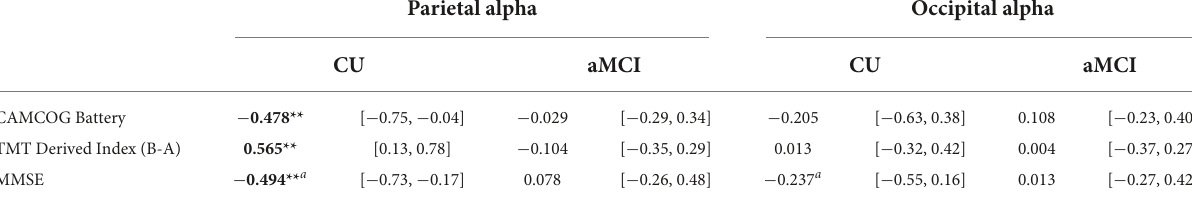
TABLE 7 Correlation coefficients (Pearson’s r ) and correspondent 95% CI between eLORETA source solutions (normalized alpha current source density) of parietal and occipital alpha rsEEG rhythms and neuropsychological test scores for CU and aMCI groups. Parietal alpha